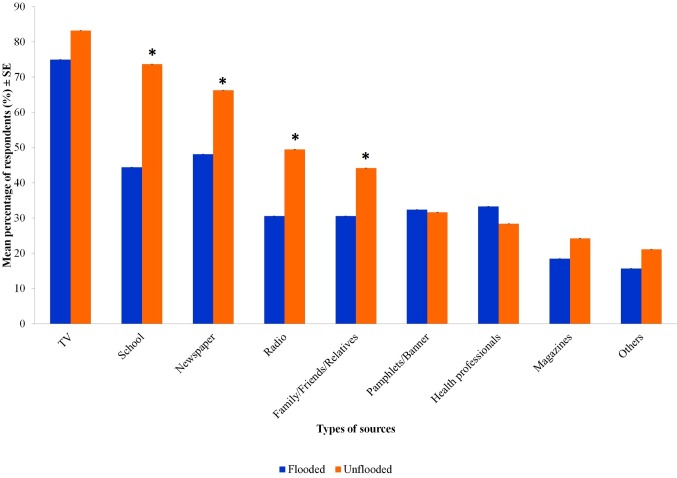
Graph showing the respondents' source of information on the dengue in both study sites.Comparison using Independent t-test, values followed by identical letter do not differ significantly, P<0.05 between flooded and unflooded areas.